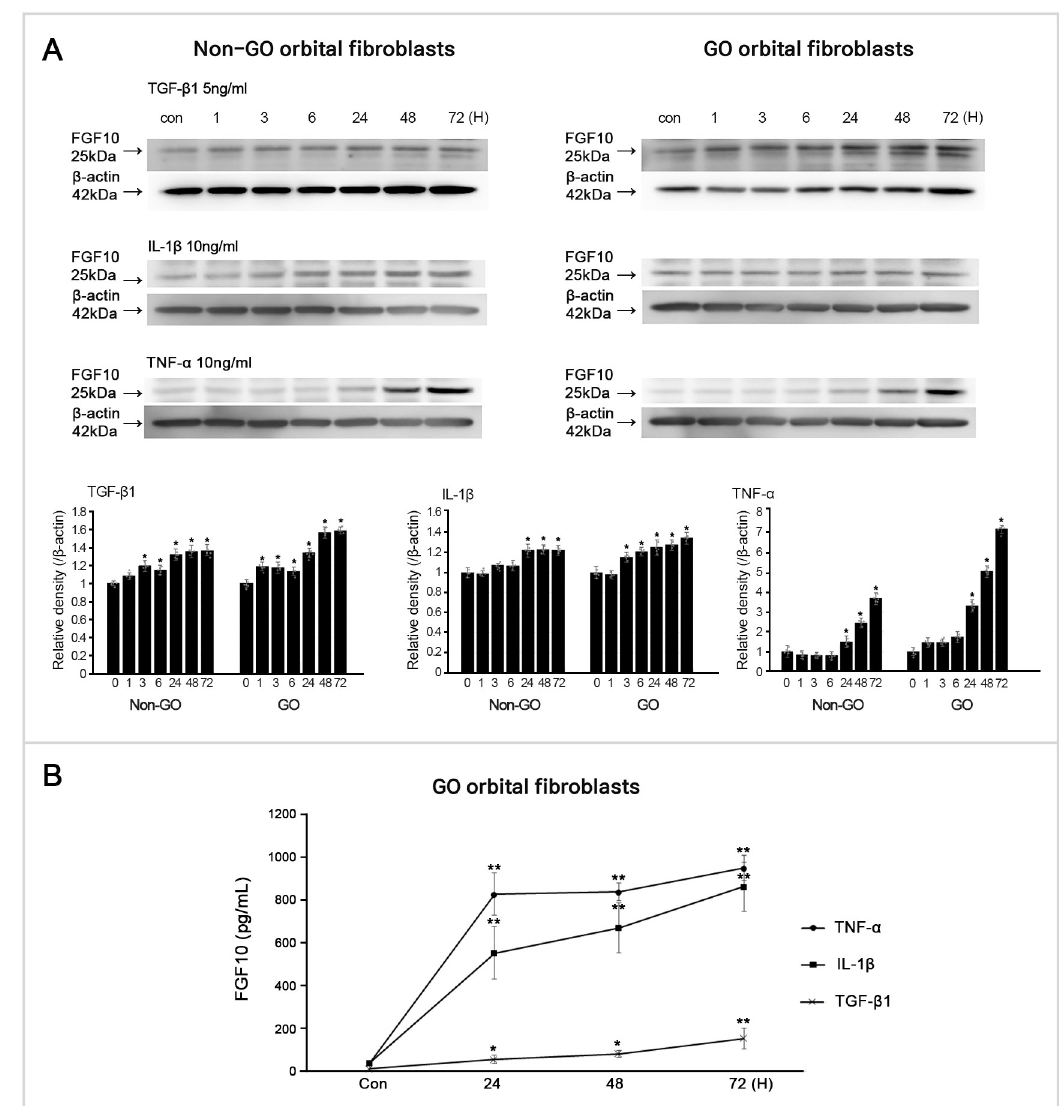
Fig 4. Effect of transforming growth factor (TGF)- β 1, interleukin (IL)-1 β , and tumor necrosis factor (TNF)- α on fibroblast growth factor 10 (FGF10) expression in Graves 0 orbitopathy (GO) and non-GO orbital fibroblasts (OFs). (A) Representative western blot images showing that TGF- β 1, IL-1 β , and TNF- α increased expression of FGF10 at various time points (0–72 h) in both GO and non-GO OFs. Bar graphs show the relative density of each protein normalized to the level of β -actin and are represented as means ± standard deviation. (B) Expression levels in GO OFs of secreted FGF10 protein in response to TGF- β 1, IL-1 β , and TNF- α , using ELISA. Experiments were performed at least three times using different strains. � p < 0.05.